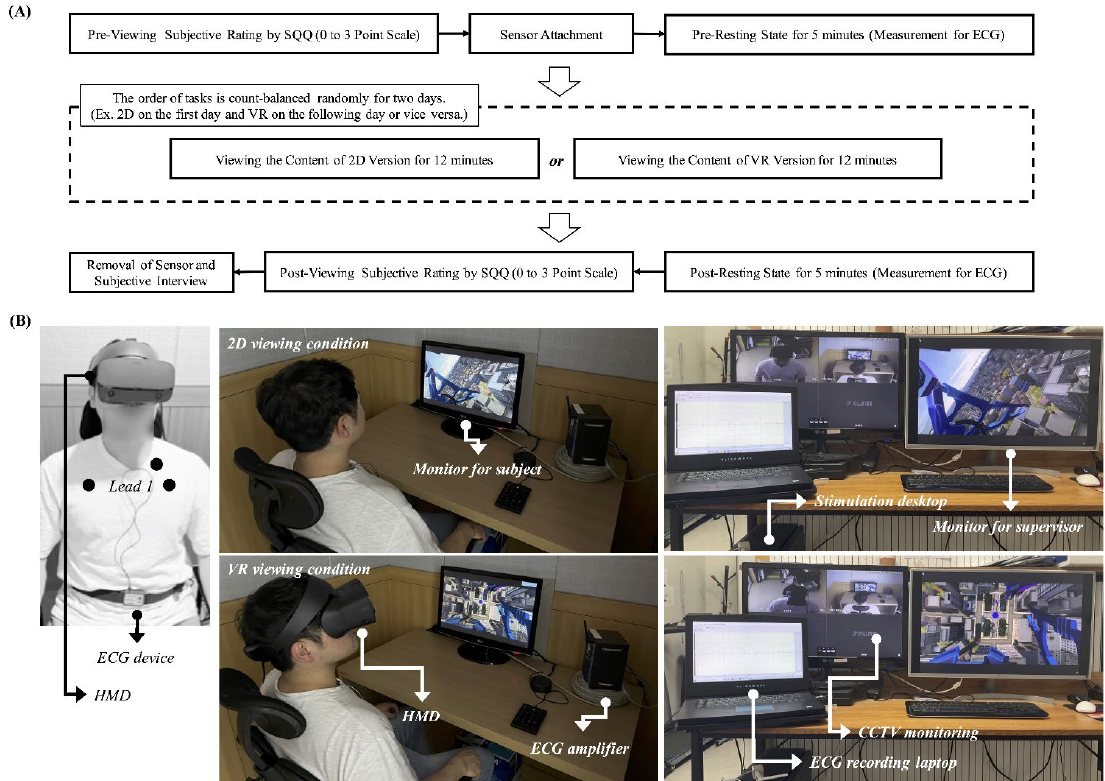
Figure 1. ( A ) Experimental procedure and ( B ) environment.